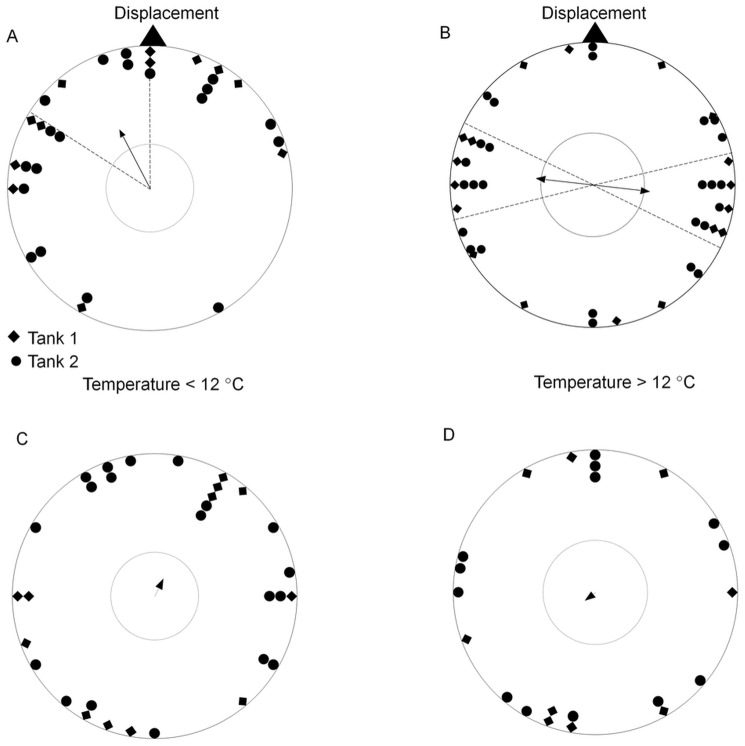
Orientation of Anguilla anguilla under four artificial magnetic conditions at temperatures between 6 and 17°C. Eels taken from training tank 1 are represented by diamonds and eels taken from training tank 2 are denoted by circles. Bearings (relative to magnetic North) were standardized relative to the direction of displacement. The triangular symbol represents the direction of displacement. The center arrow shows the mean angle of the group weighed by r (scaled 0–1) and the 95% confidence interval. The inner circle represents a significance level of 5% for the Rayleigh test. A and B are bearings standardized to the direction of the magnetic field; C and D are topographical bearings (relative to geographic north). A and C: Tests carried out at temperatures <12°. B and D: Tests carried out at temperatures >12°. Bearings on B have been doubled as they displayed significant bimodal distribution.